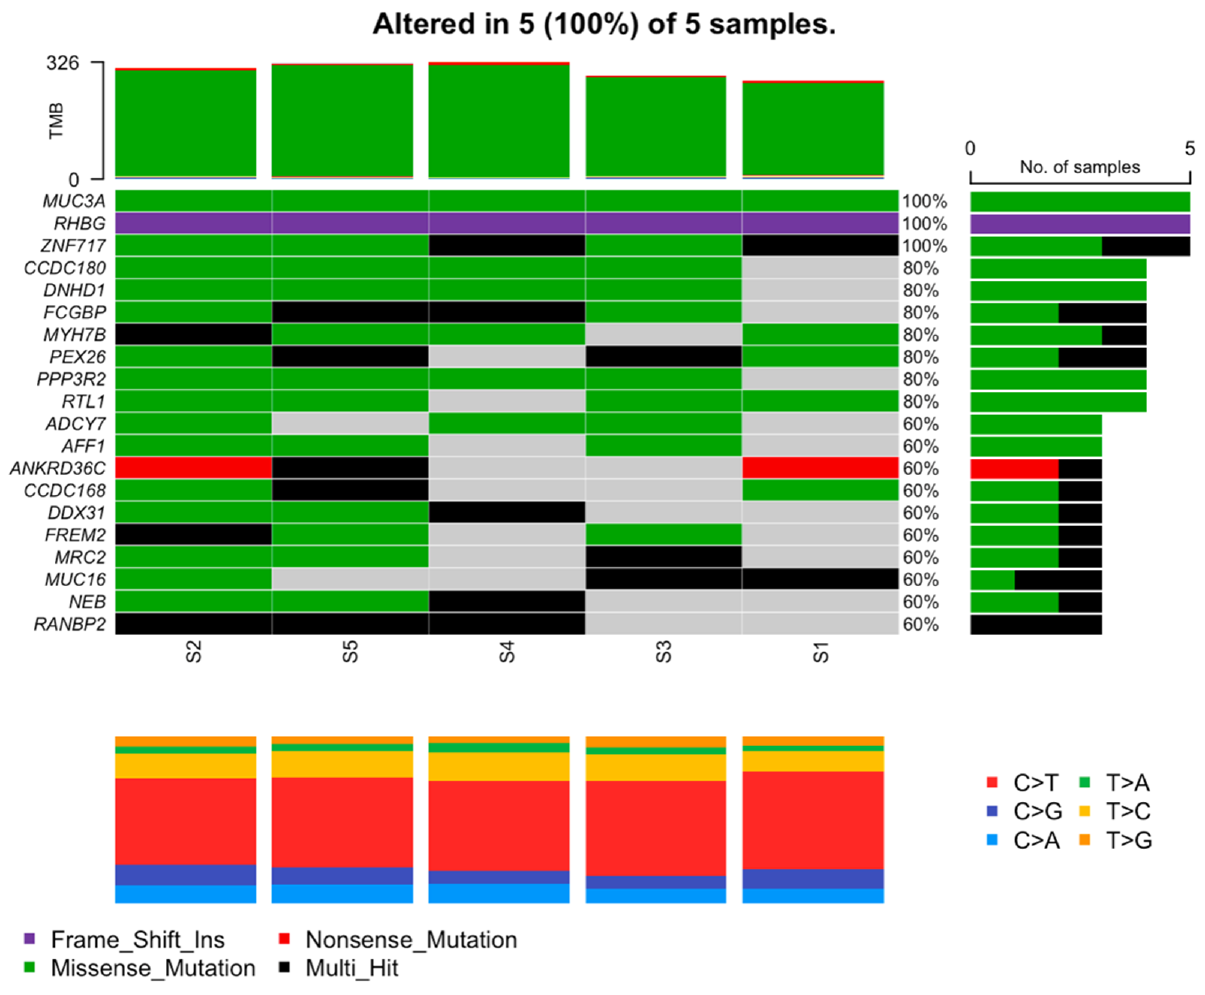
Figure 4. Mutation characterization of most mutated genes. Each column represents a patient; rows are genes. Here, green represents missense mutations, purple represents frameshift insertions, red represents nonsense mutations, and black represents multi-hit mutations. Gray is interpreted as no mutations found.